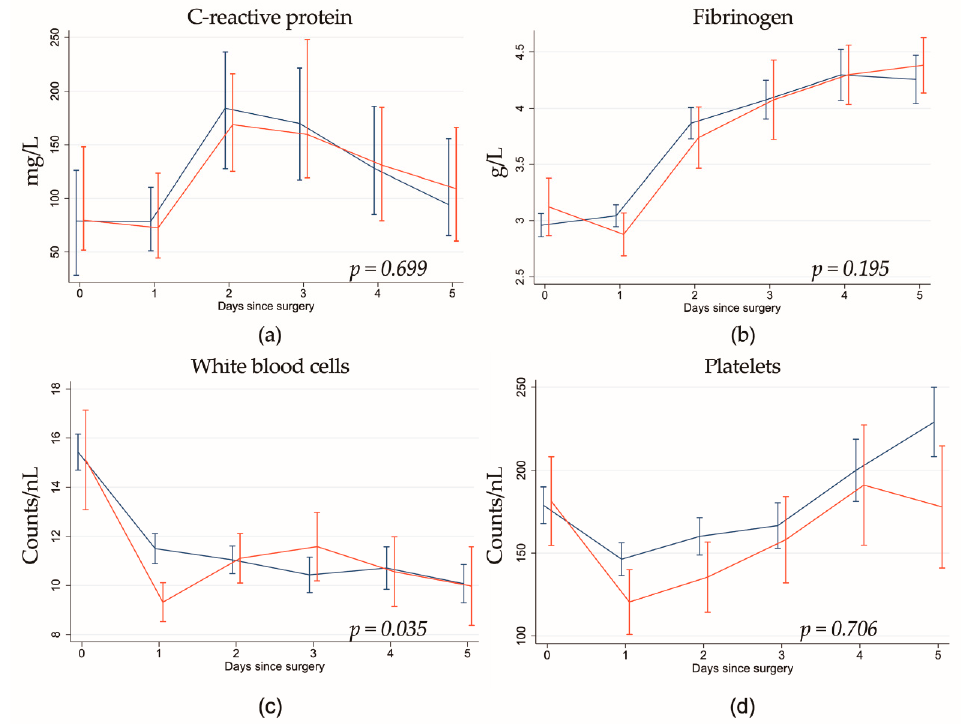
Figure 2. Postoperative development of ( a ) C-reactive protein, ( b ) fibrinogen, ( c ) white blood cells, and ( d ) platelets in hemoadsorption (red) vs. control (blue) group. White blood cell counts were decreased on the first postoperative day in the hemoadsorption group, which evened out until day five. Hemoadsorption did not show any further association with any other marker, and we could not observe any interaction of hemoadsorption and time. Given p -values are for interaction.